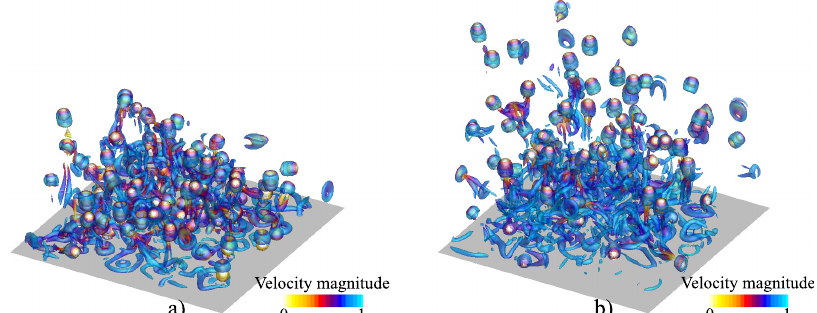
Figure 18. Instantaneous distribution of second invariant of velocity tensors ( Q = 0.1) for scheme B050: ( a ) t * = 40, ( b ) t * = 50. The color of the isosurface represents the magnitude of the velocity.